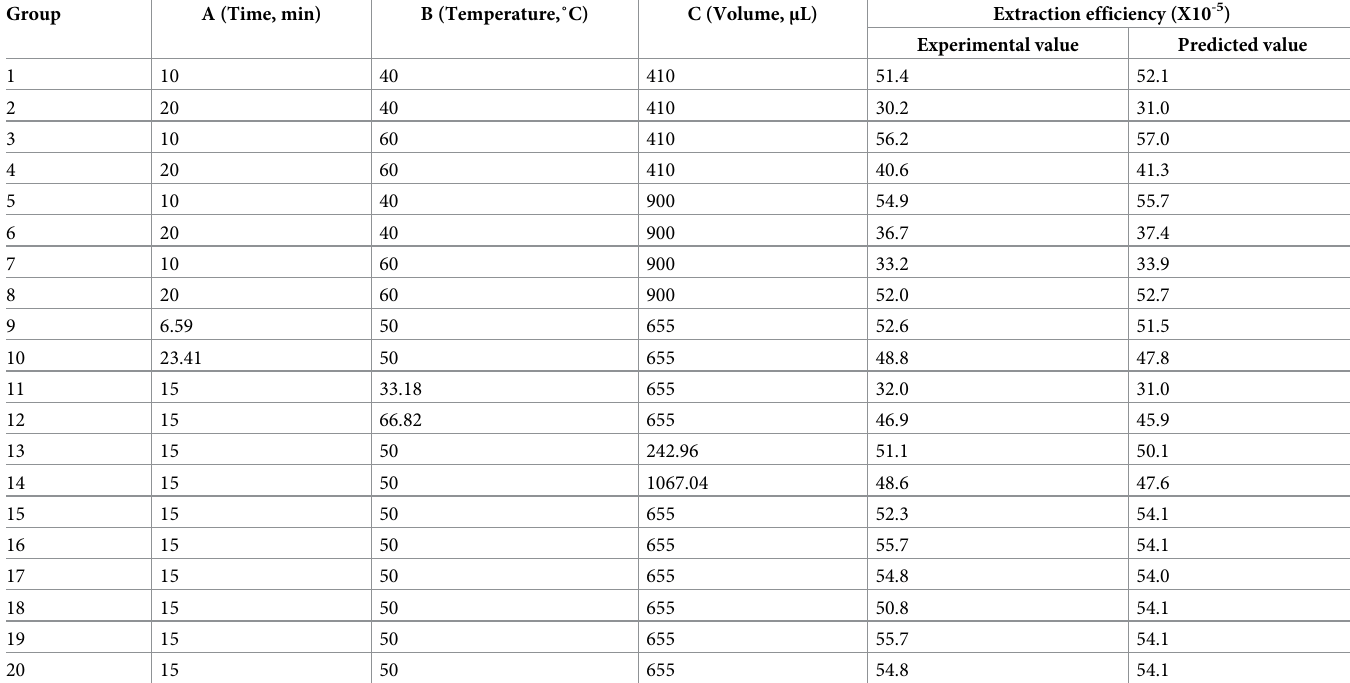
Table 3. Results of extraction efficiency of